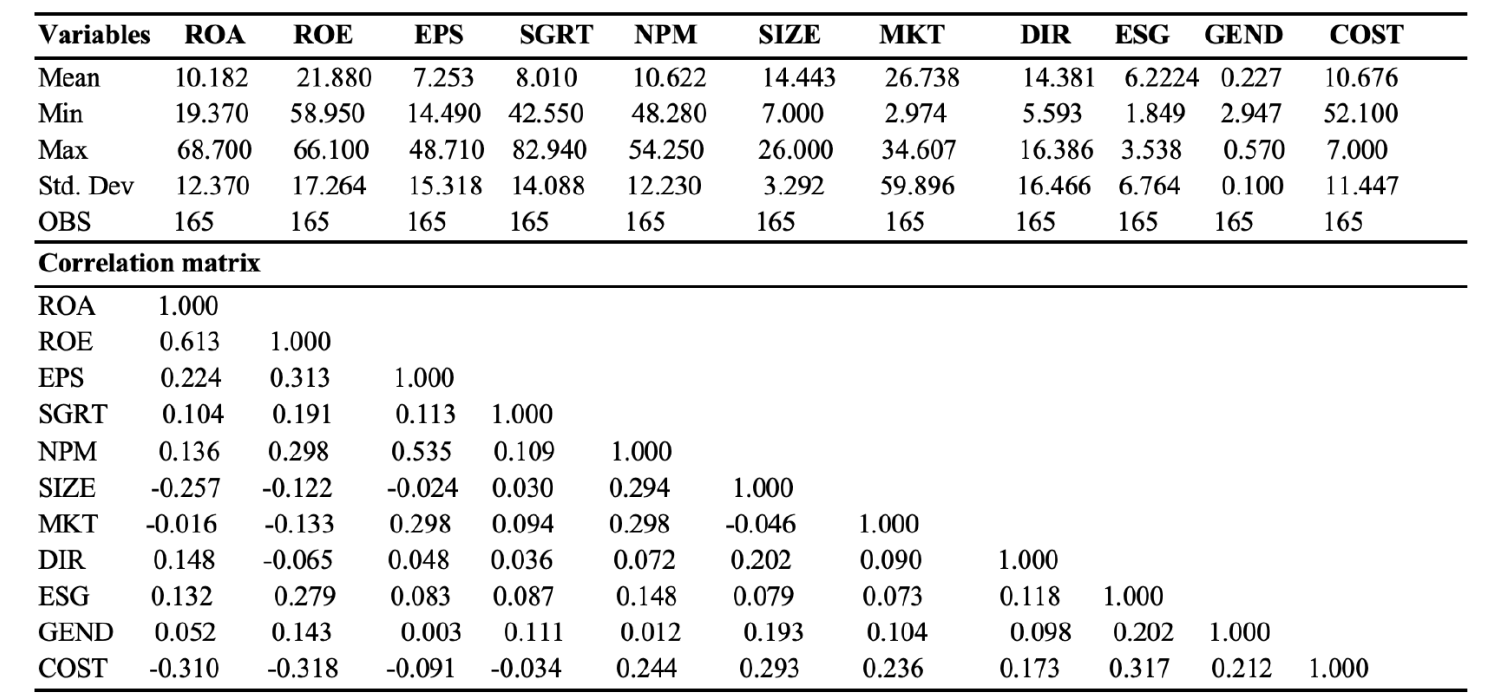
Table 1: Summary of descriptive statistics and correlation